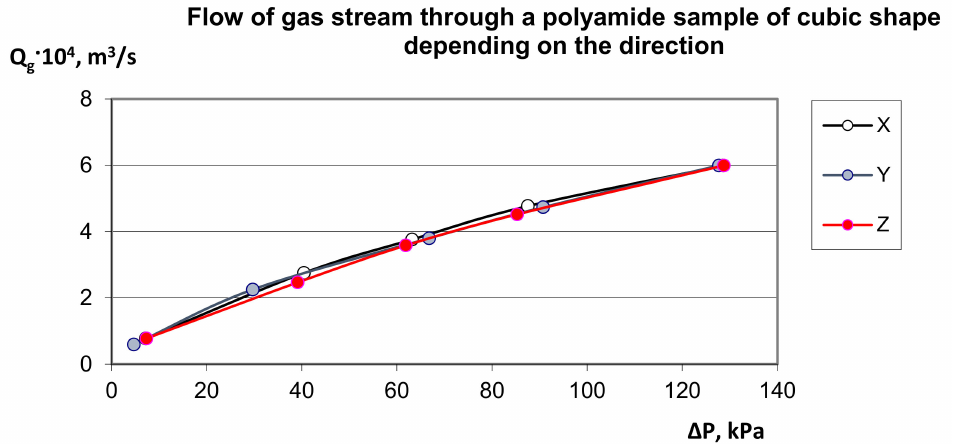
Figure 3. Distribution of experimental points characterizing the air flow Q g by depositing a cube- shaped sample of polyamide with dimensions of 20 mm × 20 mm × 20 mm, with reference to for the measured flow resistance ∆ P depending on the direction of flow, i.e., X, Y and Z.